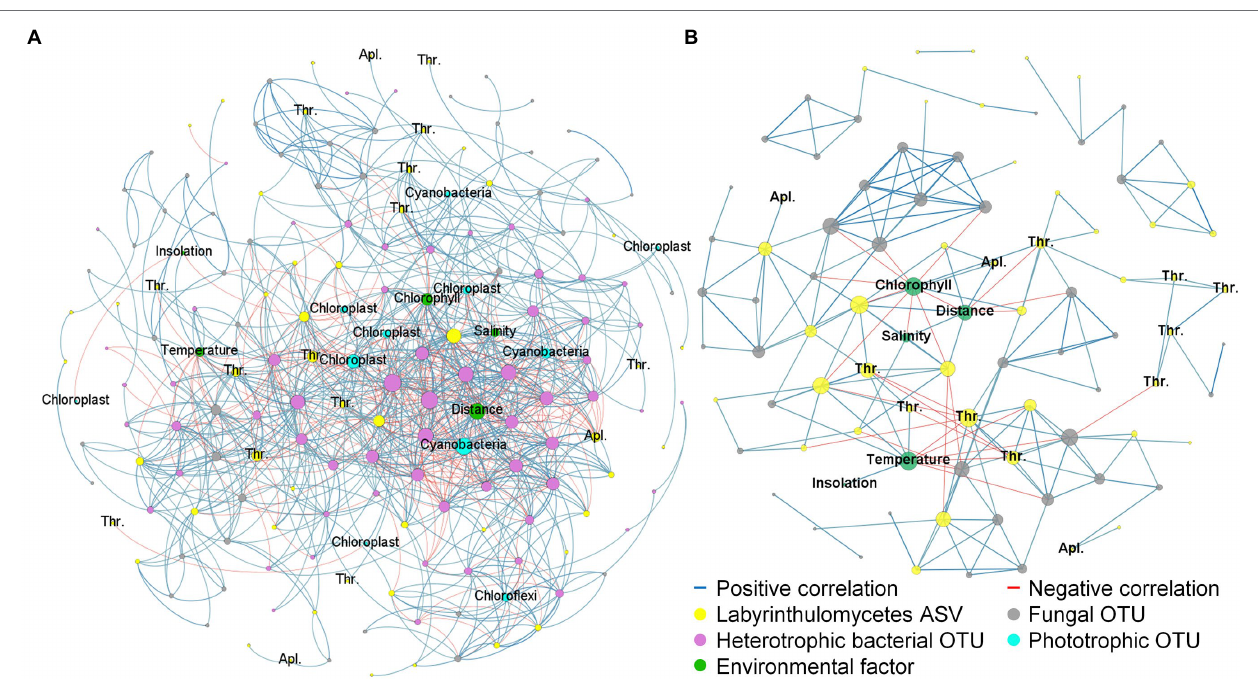
FIGURE 6 | Network (A) showing strong Spearman correlations (| ρ | > 0.6, adjusted p < 0.05) between key environmental factors and the most abundant (relative abundance >0.1%) and meanwhile prevalent (present in >10% libraries) phylotypes from Labyrinthulomycete 18S rRNA gene libraries, fungal ITS libraries, and prokaryotic/chloroplast 16S rRNA gene libraries, attached with a subset of the network (B) focusing on concurrences between Labyrinthulomycetes and